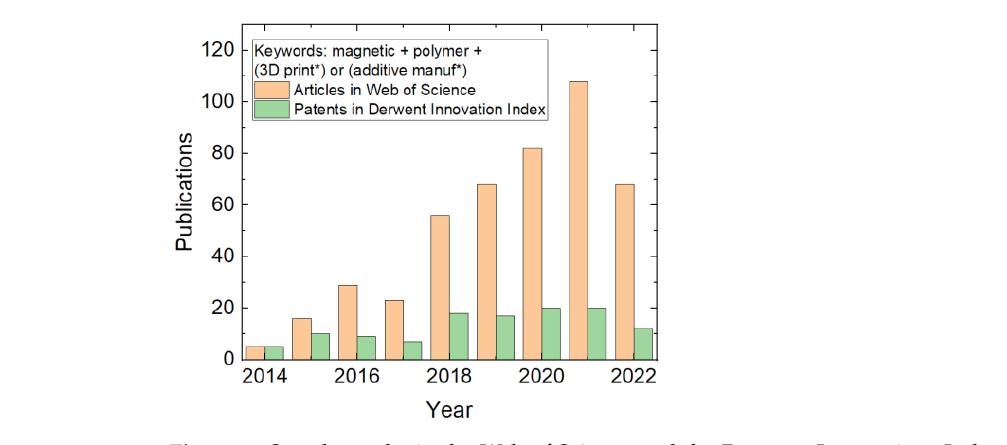
Figure 1. Search results in the Web of Science and the Derwent Innovations Index for the named keyword combinations, counted on 24 August 2022.